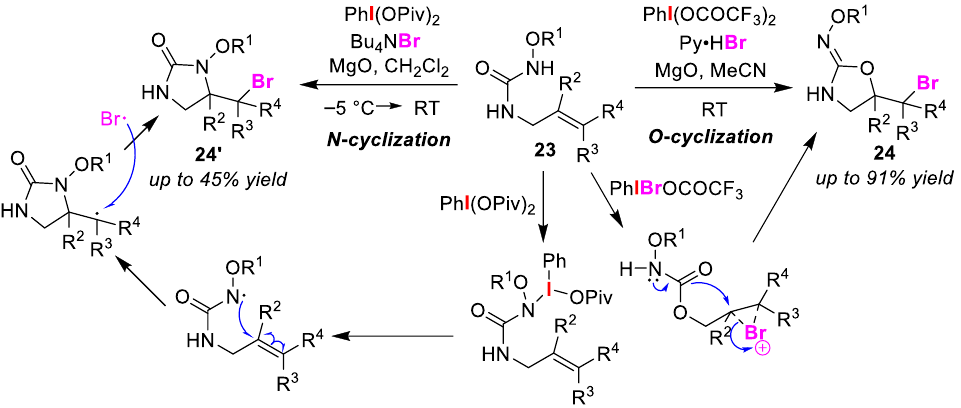
Figure 13. O/N atom-selective bromocyclizations of olefinic N -substituted ureas 23 . Figure 13. O / N atom-selective bromocyclizations of olefinic N -substituted ureas 23 . Molecules 2020 , 25 , x FOR PEER REVIEW